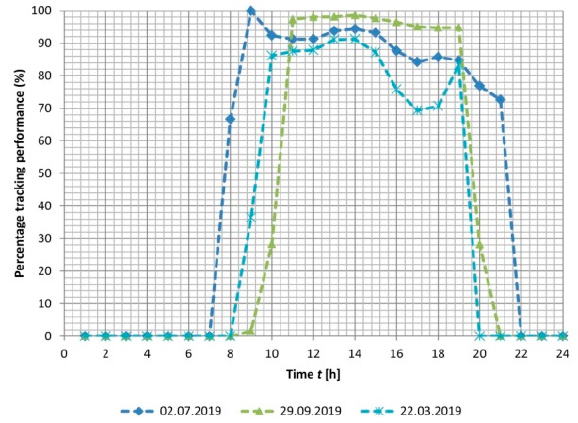
Figure 5. Percentage tracking performance compared to full tracking mode on selected days at the Solar Thermal Power Station in Spain.